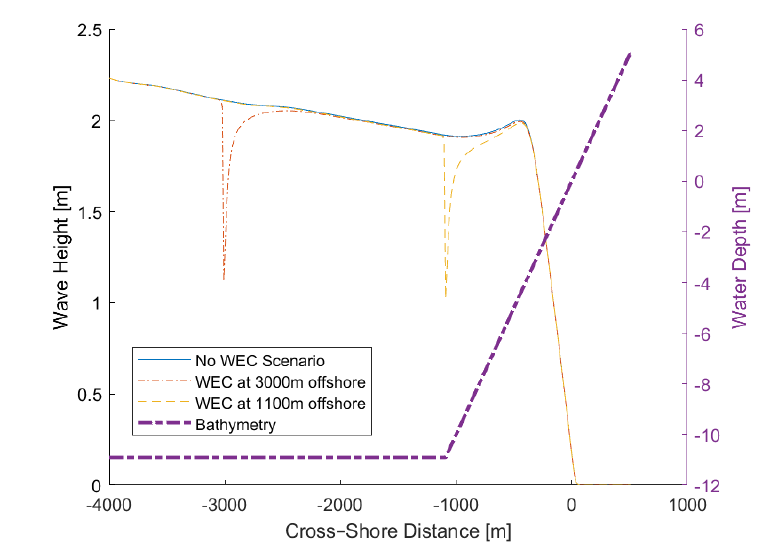
Figure 10. Cross–sectional view of the 3D XBeach wave simulation in line with the WEC, showing a comparison of the placement of two WECs for a wave height of 2.25 m and a period of 8.5 s. The waves in the lee of the − 3000 m WEC present a nearly negligible effect on the wave after 1100 m of propagation, while the WEC placed closer to shore shows a small decrease in the wave height at the break